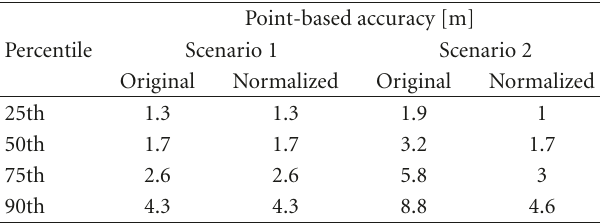
Table 1: Comparison of point-based accuracies for Scenario 1 and Scenario